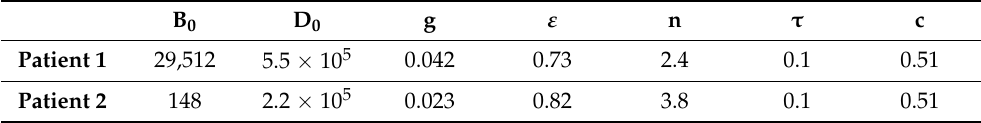
Table 4. Model parameter values for Patient 1 and Patient 2 of [7].